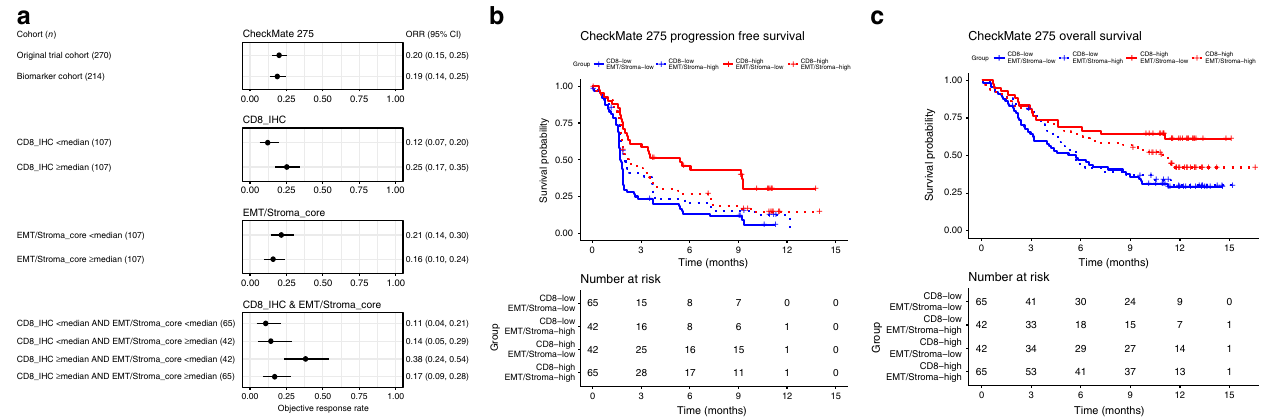
Fig. 6 Higher EMT/Stroma-related gene expression is associated with an attenuated response to PD-1 blockade in T-cell in fi ltrated UC. a Objective response rate estimates with the PD-1 inhibitor, nivolumab, in the CheckMate 275 biomarker cohort, by CD8 and EMT/Stroma_core subgroup ( n = 214). Subgroups are de fi ned by biomarker score ≥ or < the median score. Plotting symbols show objective response rate point estimates; error bars show 95% con fi dence intervals for objective response rate. Kaplan – Meier estimates of b PFS and c OS curves in patients in the CheckMate 275 biomarker cohort, strati fi ed according to the four biomarker